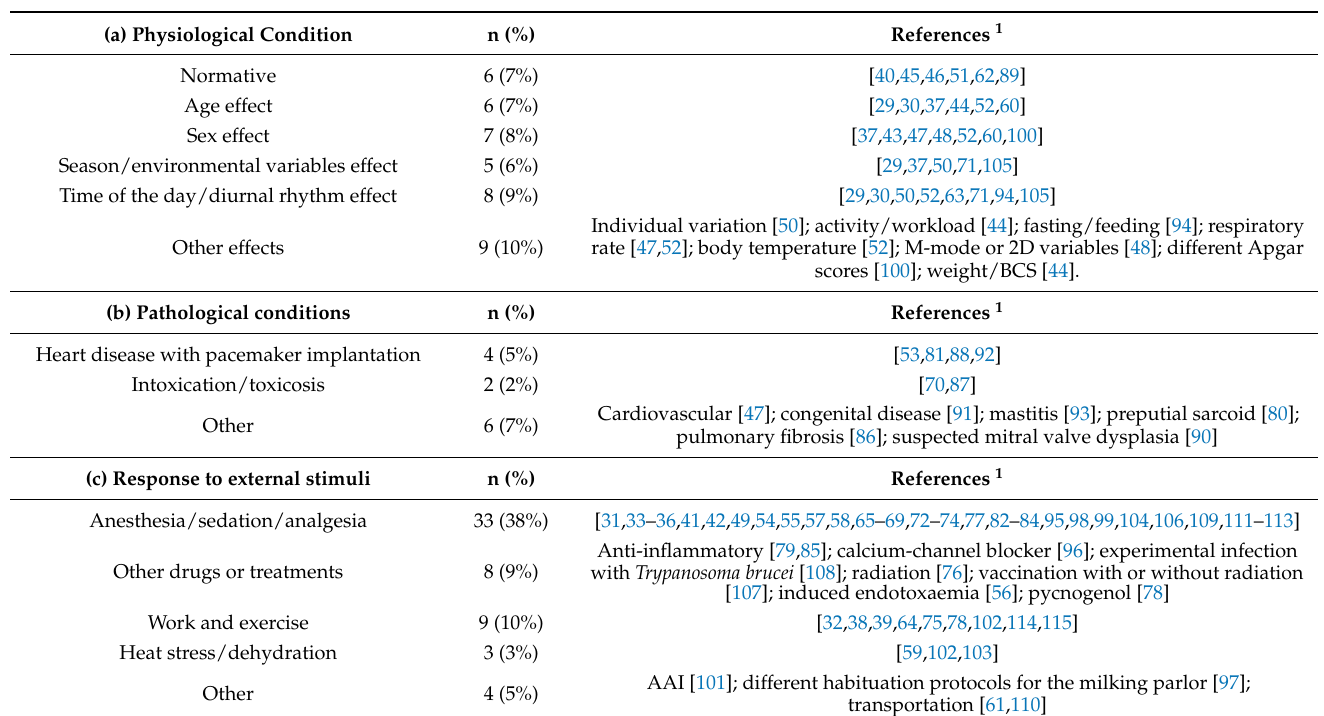
Table 6. HR/HRV applications (n =